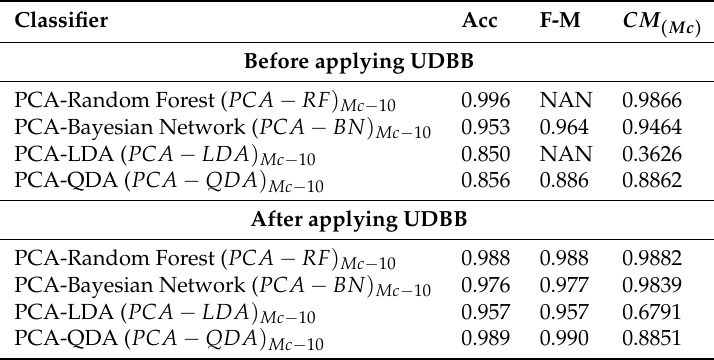
Table 14. Performance evaluation of ( PCA − X ) Mc − 10 .